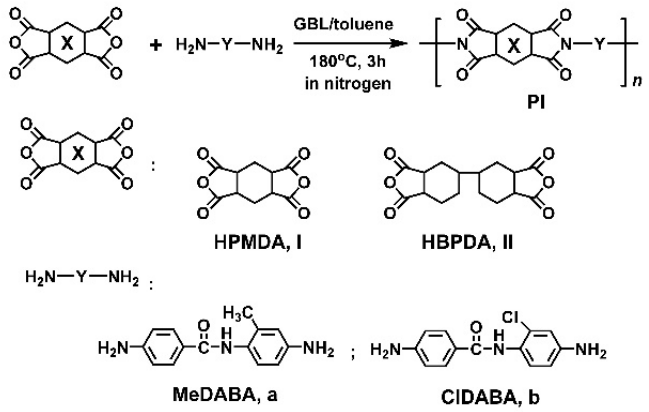
Figure 1. Preparation of semi-alicyclic amide-bridged PIs. Table 1. Inherent viscosities, molecular weights, and solubility of SPI resins.